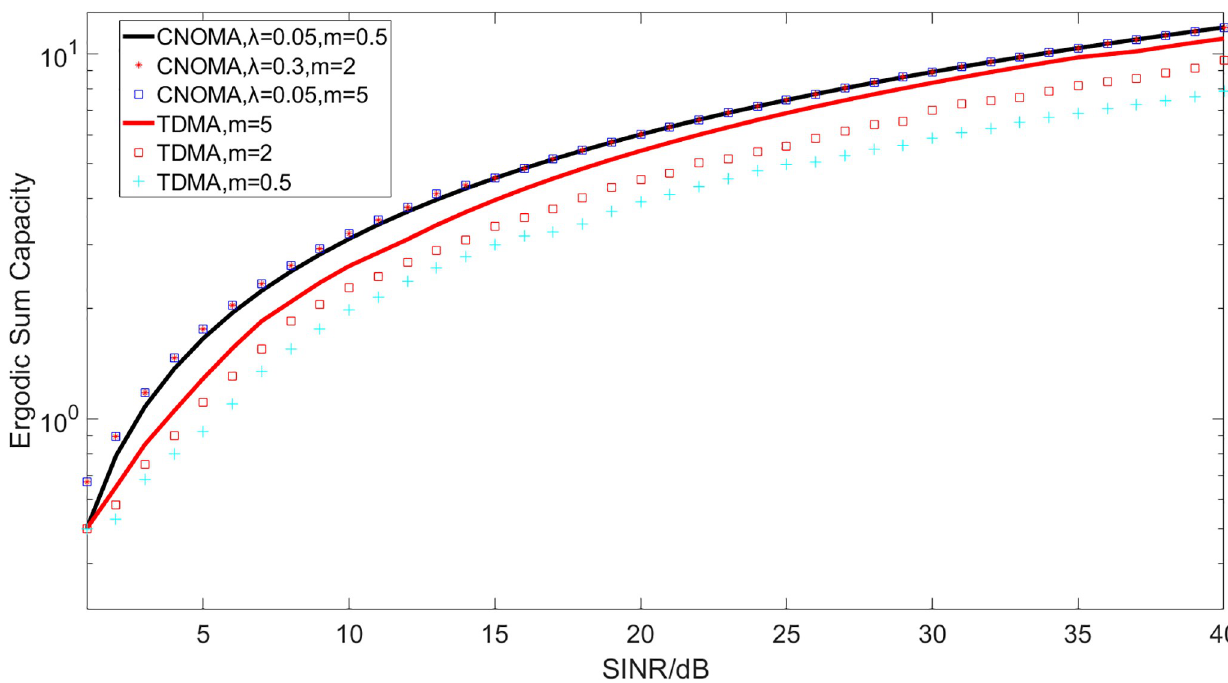
Fig 3. Ergodic sum